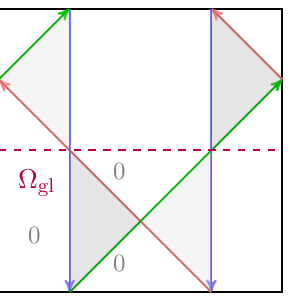
Figure 15a. The toric diagram of C 2 / Z 2 × C . Figure 15b. The five-brane di-